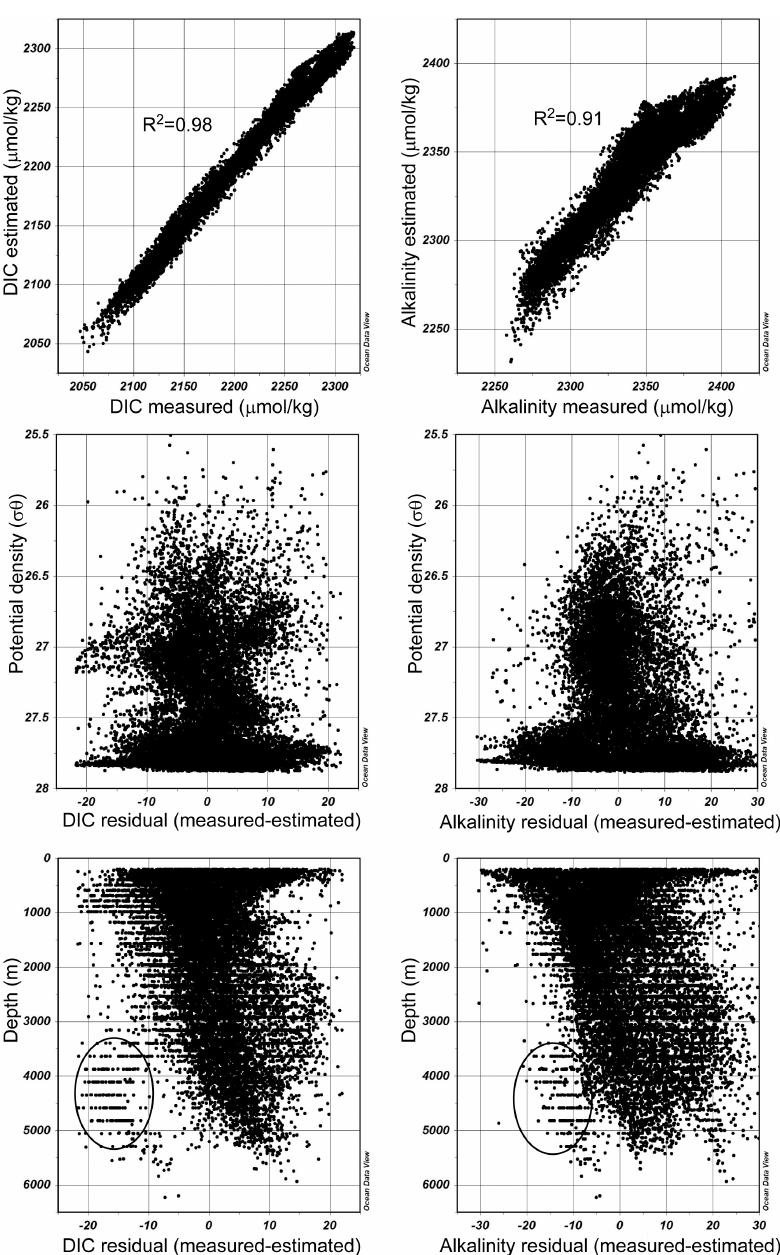
Fig. 4. Measured alkalinity and DIC versus estimated from the MLR algorithm for all data points deeper than 200m and south of 25 ◦ S. Residuals are plotted against potential density and water depth. The area in the circle is data from P06 2003 from 145 ◦ W to 180 ◦ W (see text for